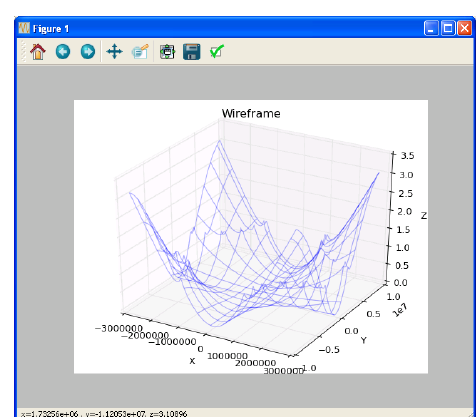
Fig.18. The surface of distortions with the scale of colours generated by the developed plug-in